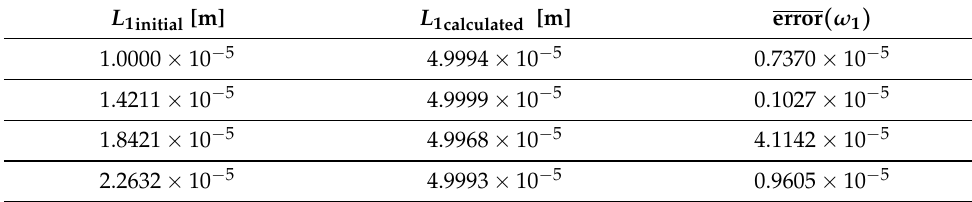
Table 2. Results for case